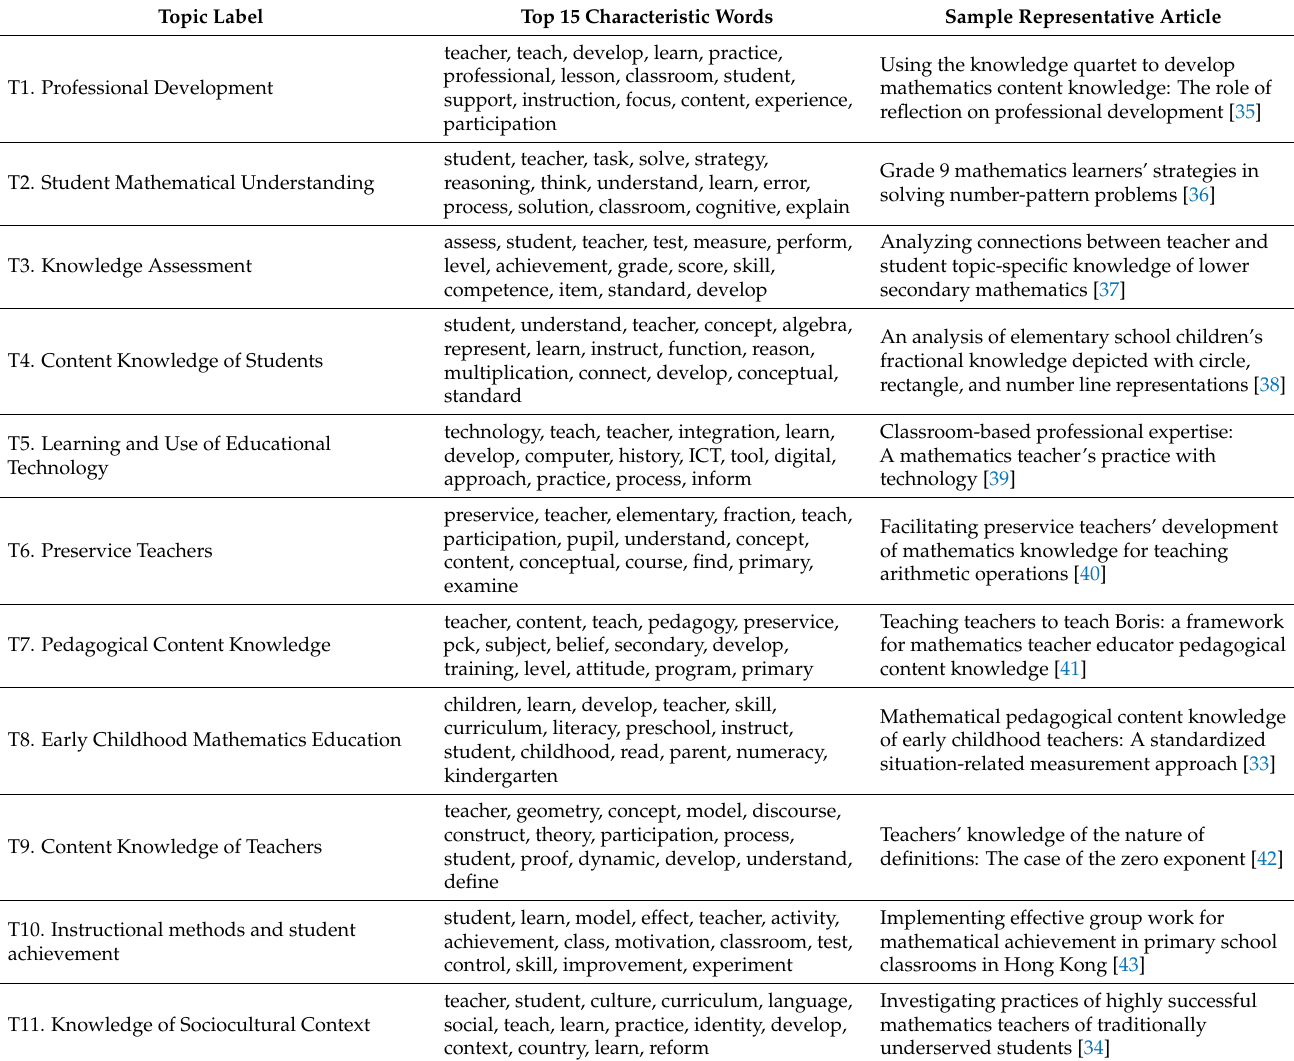
Table 4. Topic labels, characteristic words, and sample representative article of each